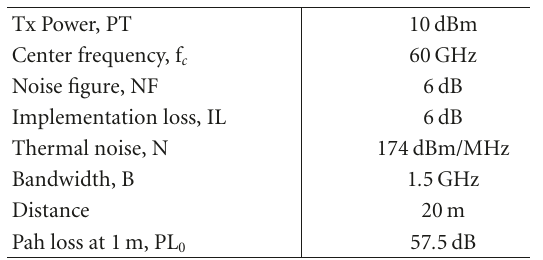
Table 4: Parameters used in the analysis.